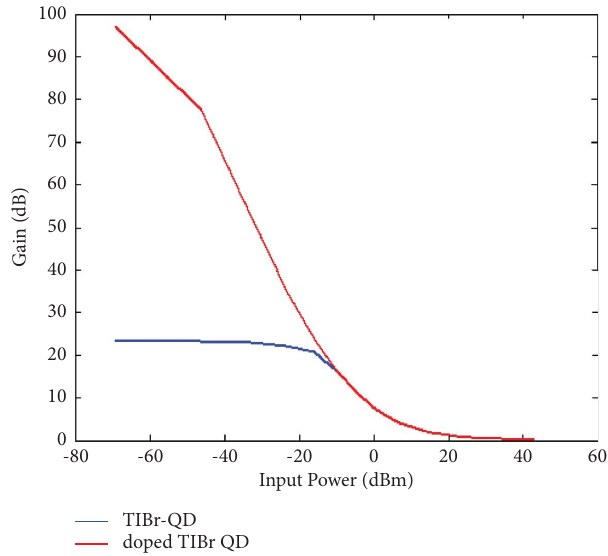
Figure 4: Gain (dB) versus input power (dBm) for doped (red) and undoped (blue) TlBr/BrCl QDs. Table 2: QD-SOA parameters used in the calculations [27].